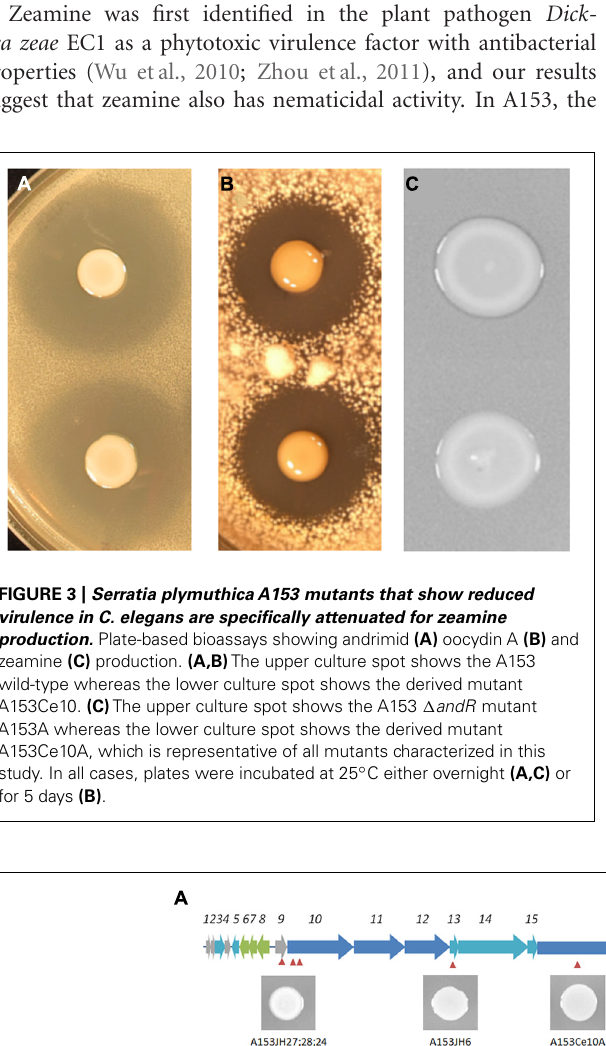
FIGURE 4 |The zeamine gene cluster is present in Serratia and Dickeya strains. Genetic organization of the zmn gene cluster sequence in S. plymuthica A153 (A) . Location of the Tn-KRCPN1 transposon insertions are indicated by red arrowheads. Inserts show mutant antibacterial phenotypes against B. subtilis after an overnight incubation